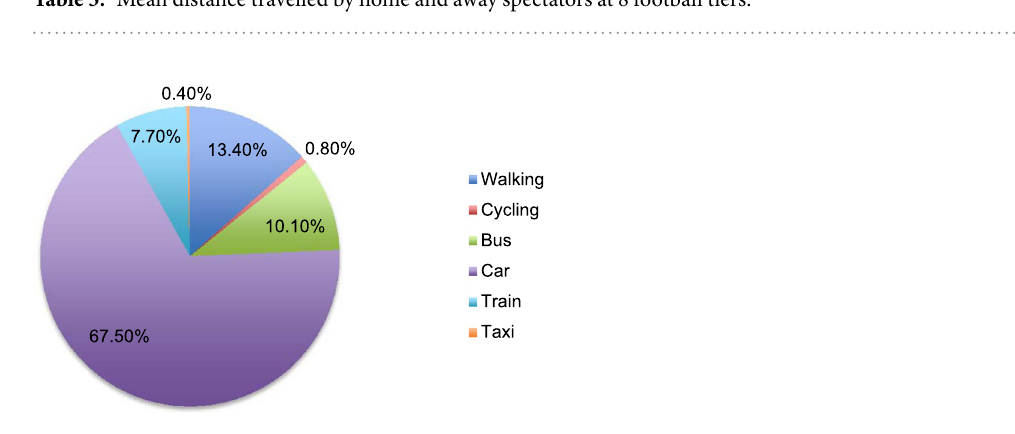
Table 3. Mean distance travelled by home and away spectators at 8 football tiers.